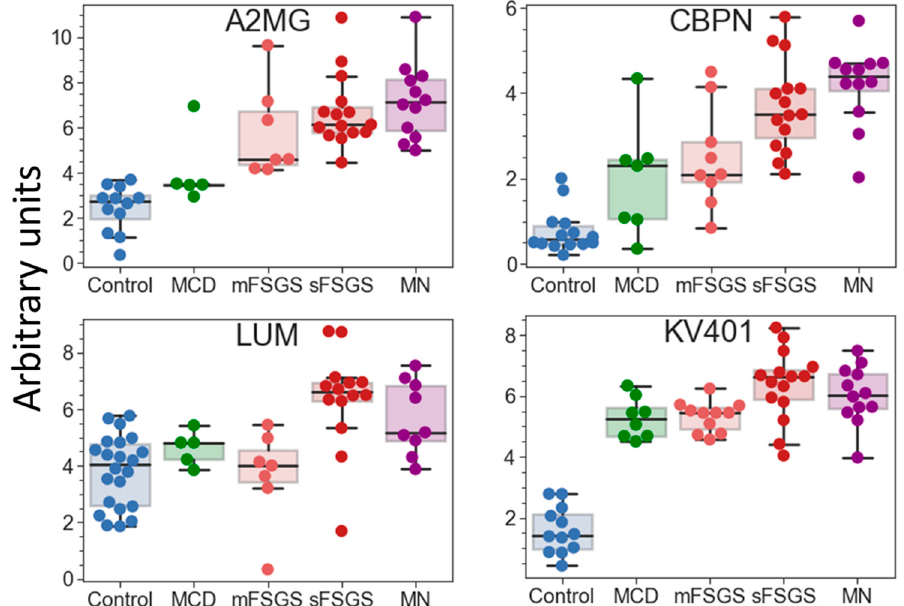
Figure 5. Boxplots for some of the potential protein markers prevalent only in certain glomerulopa- thies. The protein levels are presented in arbitrary units on an Ln(x + 1) scale. Abbreviations: